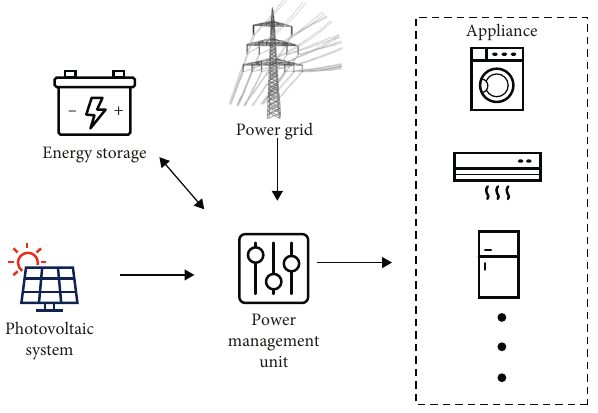
Figure 1: General layout of the hybrid